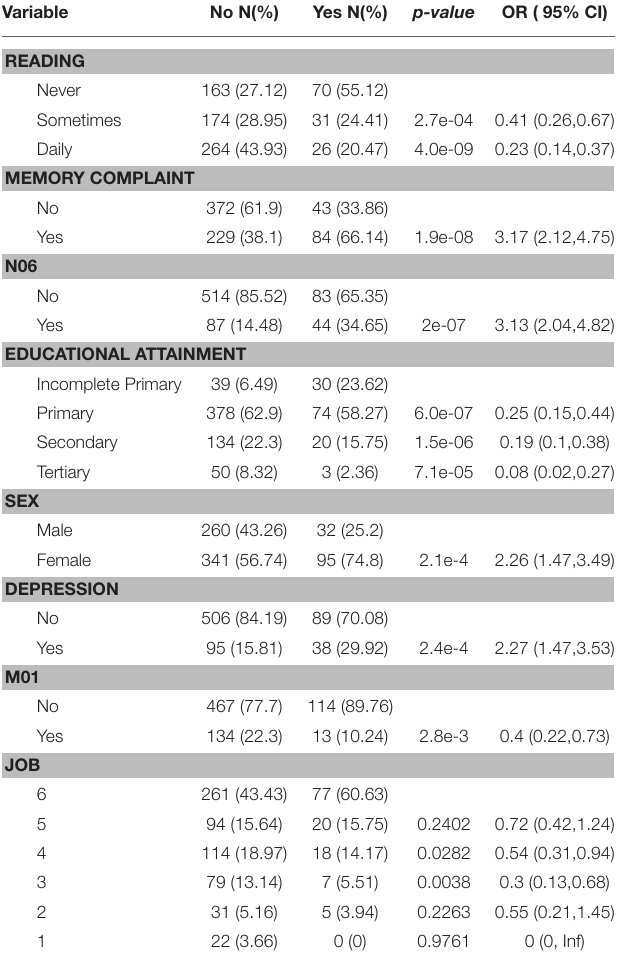
TABLE 1 | Description of odds ratios for qualitative variables with at least one category statistically significant with a univariate logistic regression for a significance level α = 0.01.